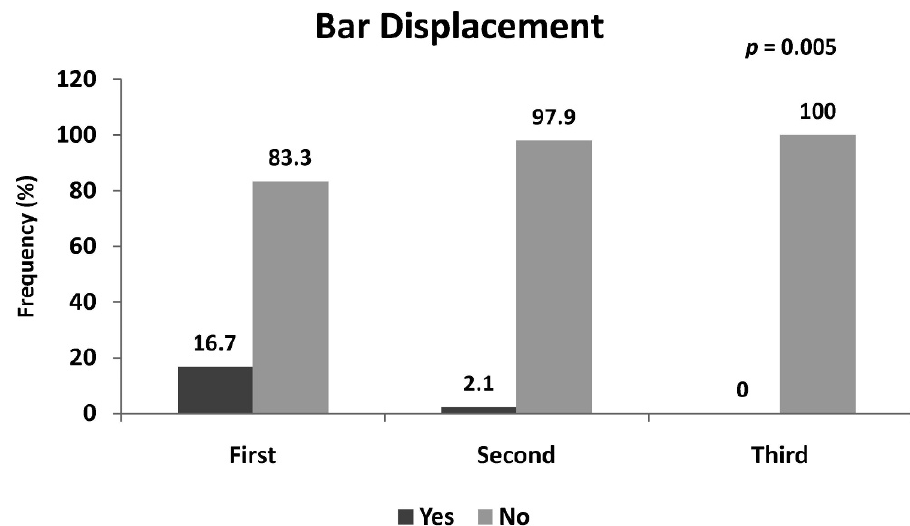
Figure 3 - The incidence of bar displacement in the three series.